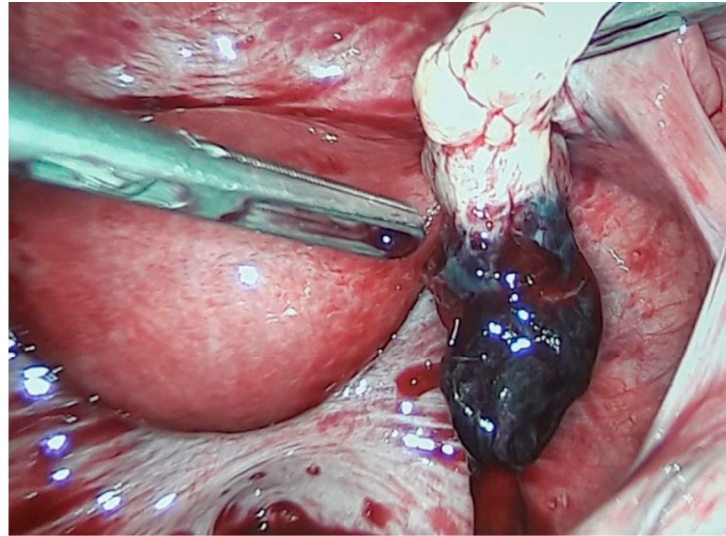
Figure 5. Laparoscopic image of an ovarian ectopic pregnancy.